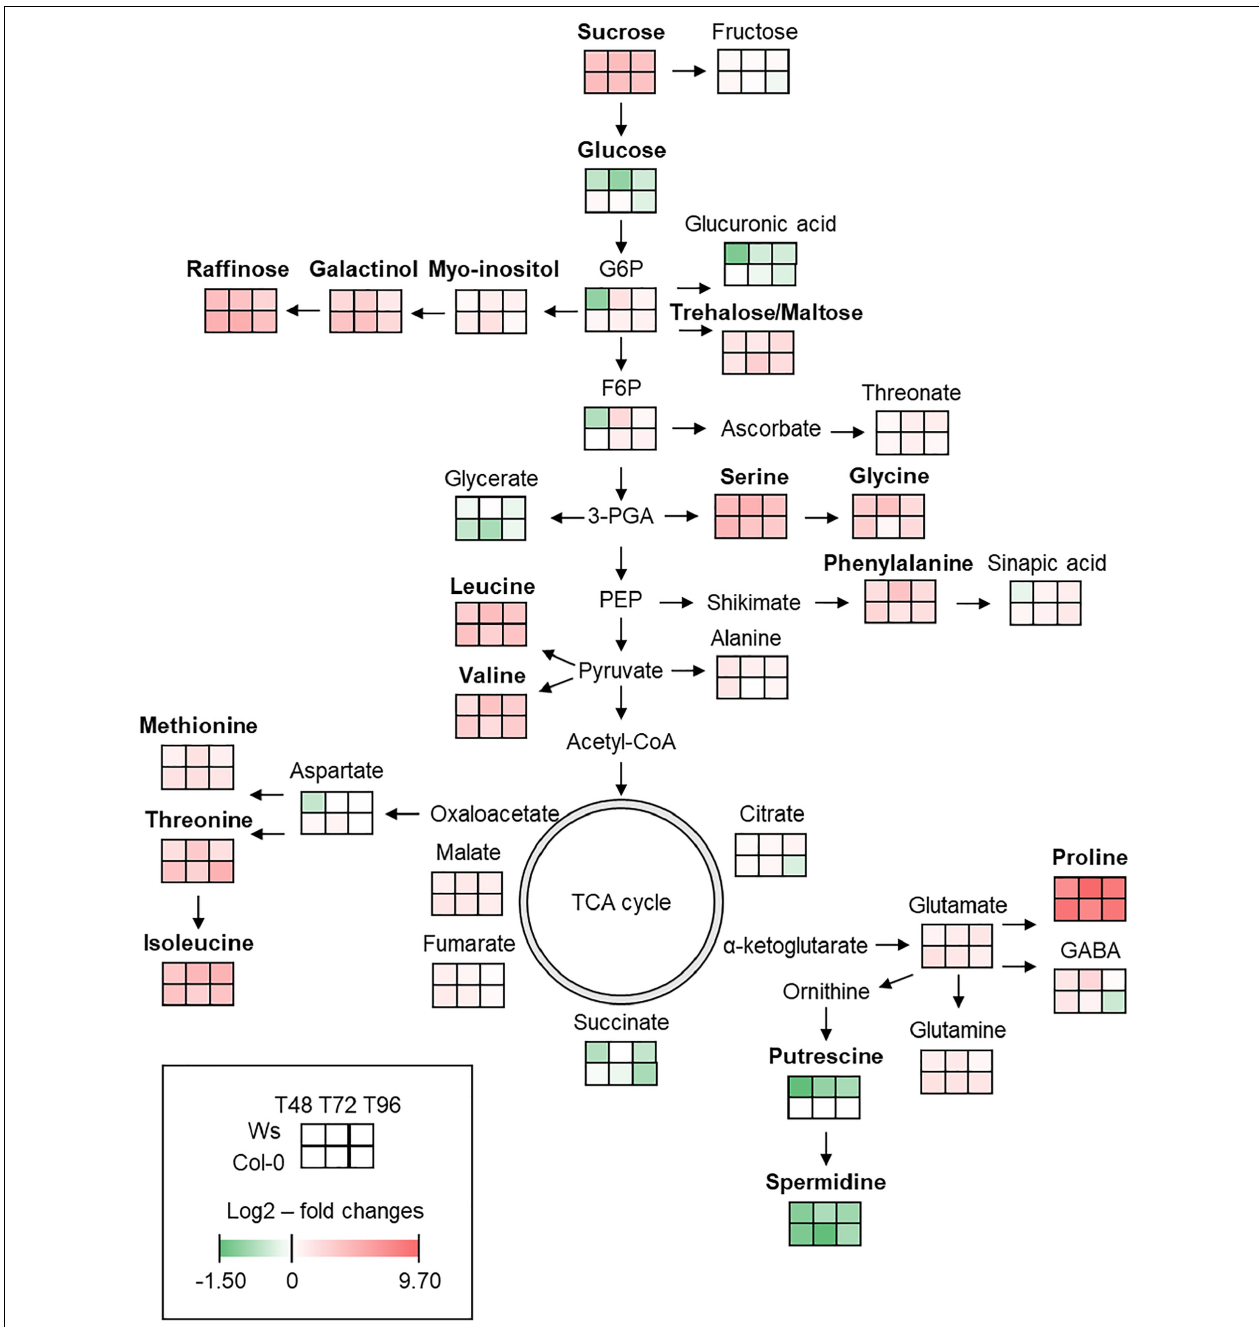
FIGURE 4 | Primary metabolic map reflecting the metabolite changes in shoot of Arabidopsis Ws and Col-0 in response to salt stress at T48, T72, and T96. Means ( n = 3) of log2–fold changes in metabolites content are represented as heatmap squares. The complete primary metabolites profile including statistical analysis can be found in Supplementary Table 1 . Green and red colors represent, respectively, a lower and a higher metabolite content in the stress condition. In bold are the most discriminant